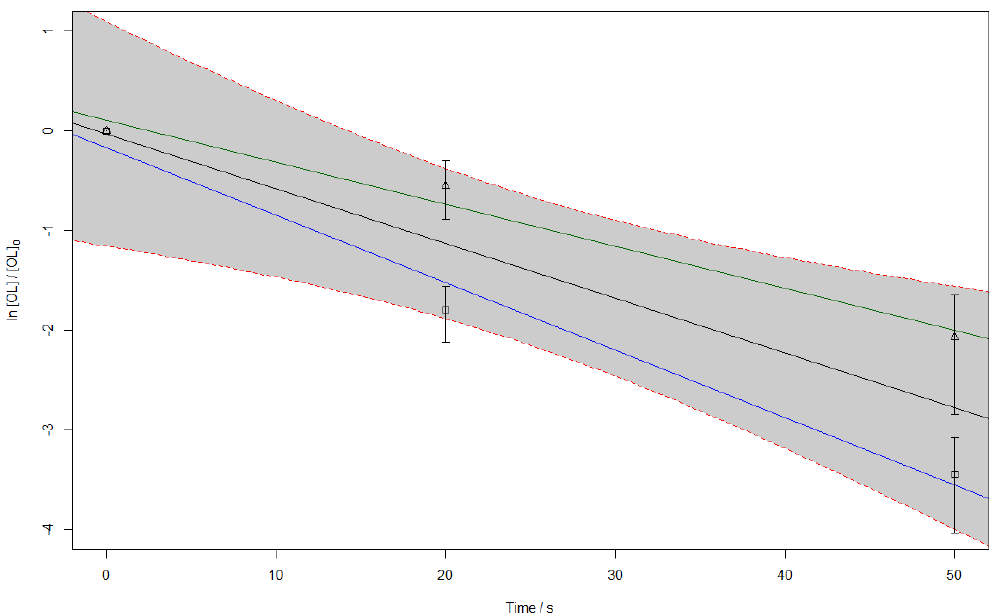
Figure 9. Reactive decay of oleic acid as a function of time for particles in the size range 0.4–0.5µm (mean particle diameter = 0.48µm). Square symbols are measurements under dry conditions (RH = 0.5%); triangle symbols are measurements under humid conditions (RH = 65%); black line is the linear fit of combined dry and humid data; blue line is the linear fit of dry data set; green line is the lin- ear fit of humid data set; grey shading is the confidence limits for the linear fit to the combined data set at the 95% confidence limits for prediction. Error bars on the individual data points are 2 × the standard error of the